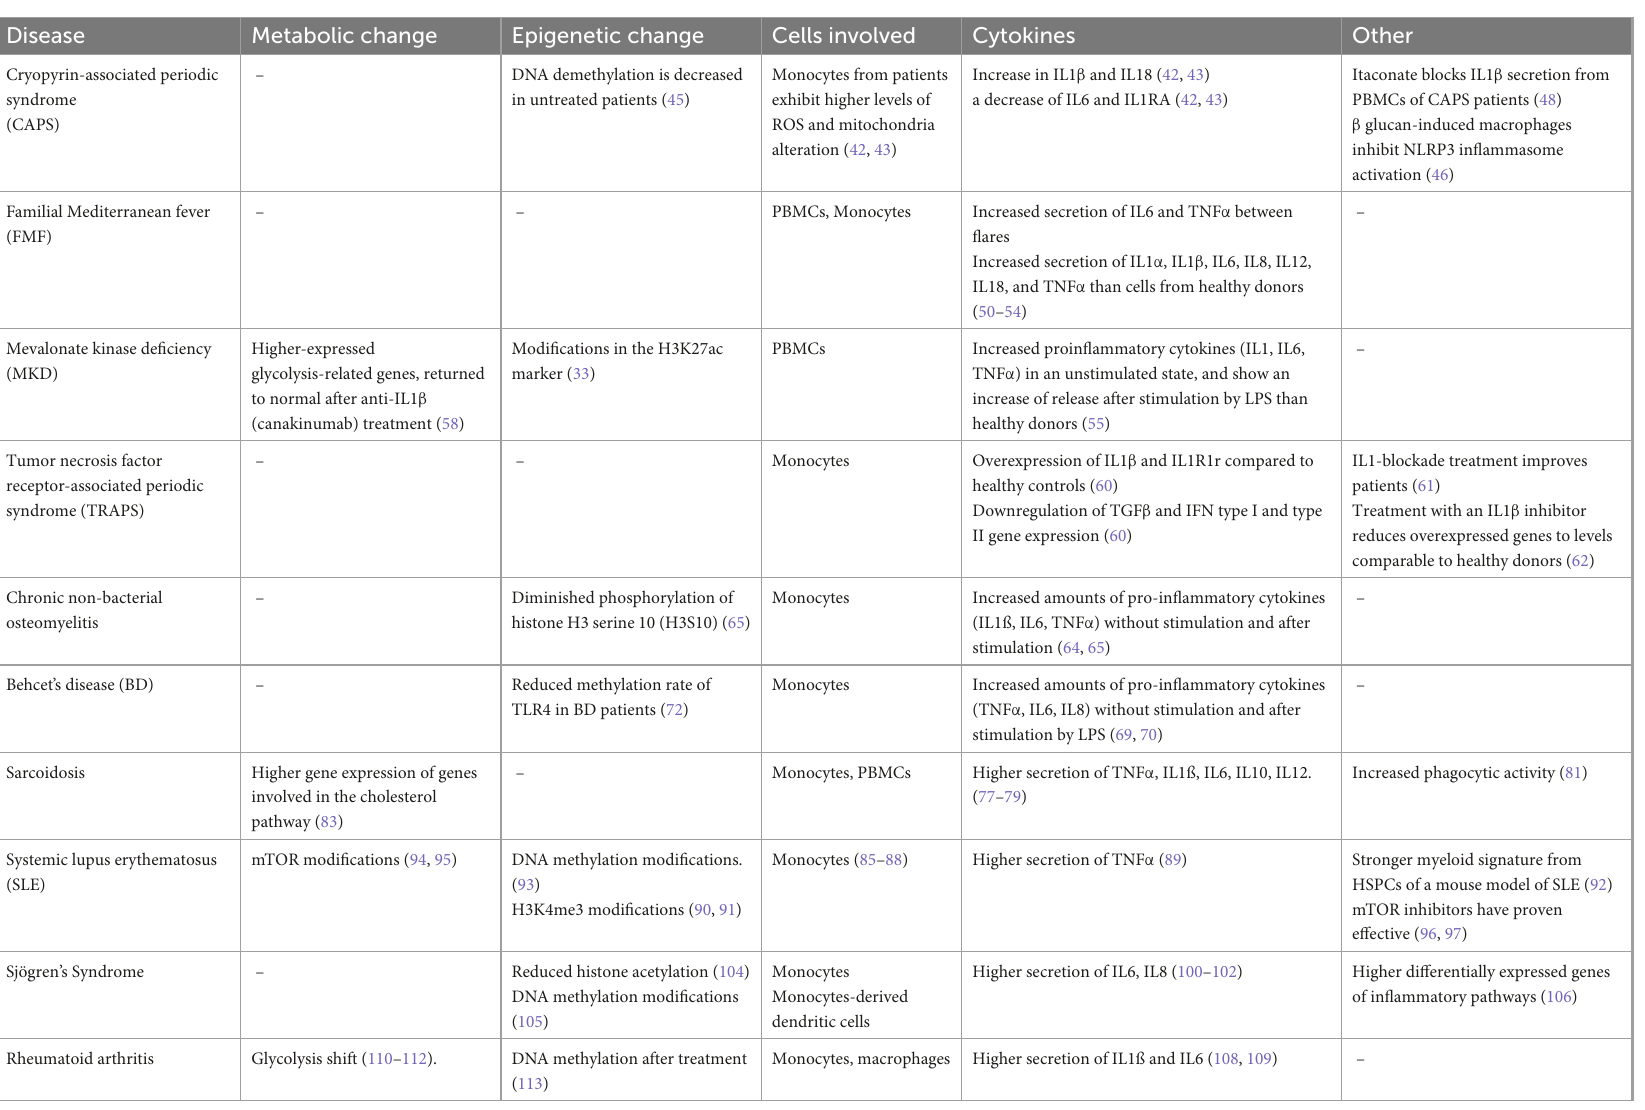
TABLE 1 Trained immunity phenotype associated with autoinflammatory and autoimmune diseases. Disease Metabolic change Epigenetic